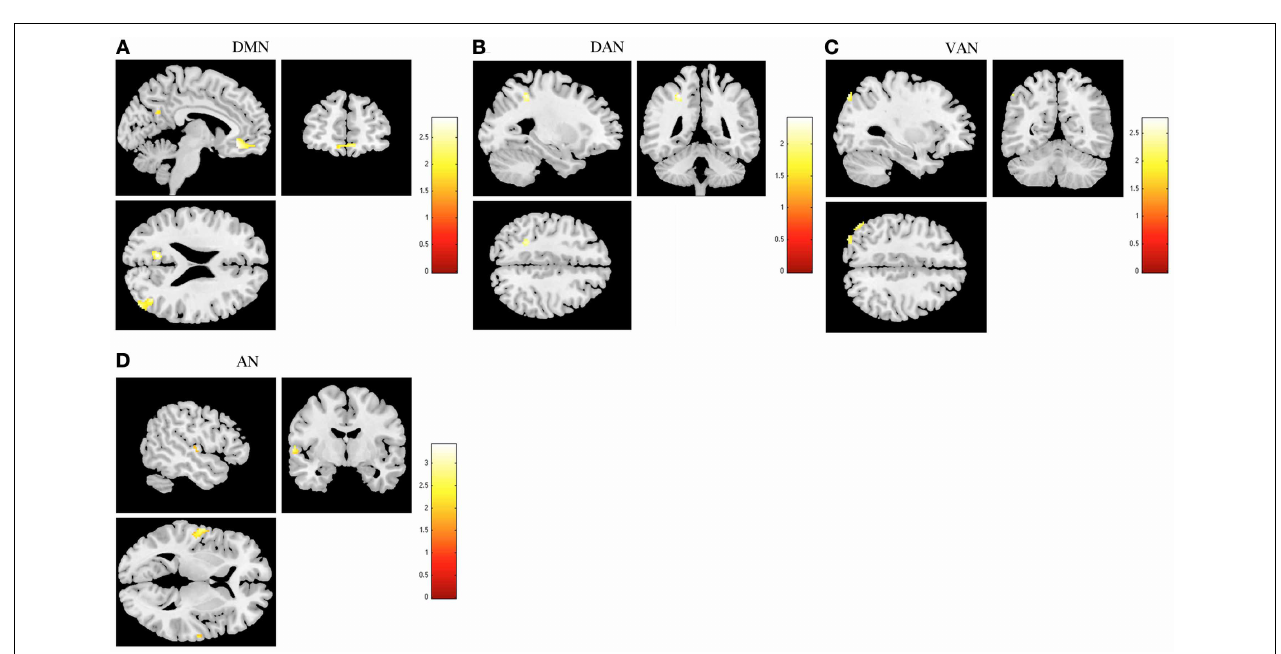
FIGURE 5 | Comparison between stress recovered participants and controls in resting state networks (RSNs) during task-induced deactivations. The images demonstrate areas of decreased deactivation in stress-recovered participants when compared to controls in the default mode network (DMN) (A) , dorsal attention network (DAN) (B) , ventral attention